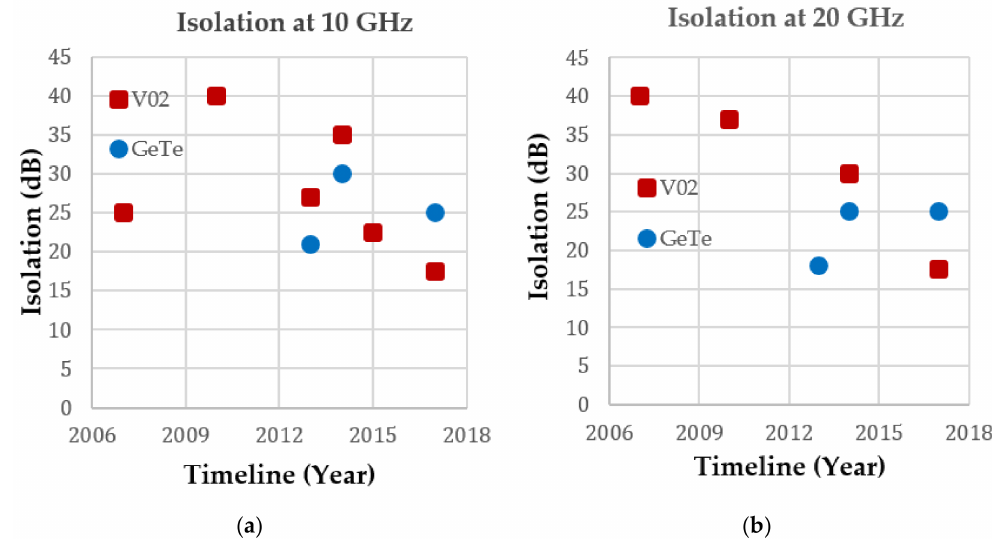
Figure 14. Progress in isolation associated with GeTe and VO 2 based switches over the years. ( a ) Isolation at 10 GHz; ( b ) Isolation at 20 GHz.